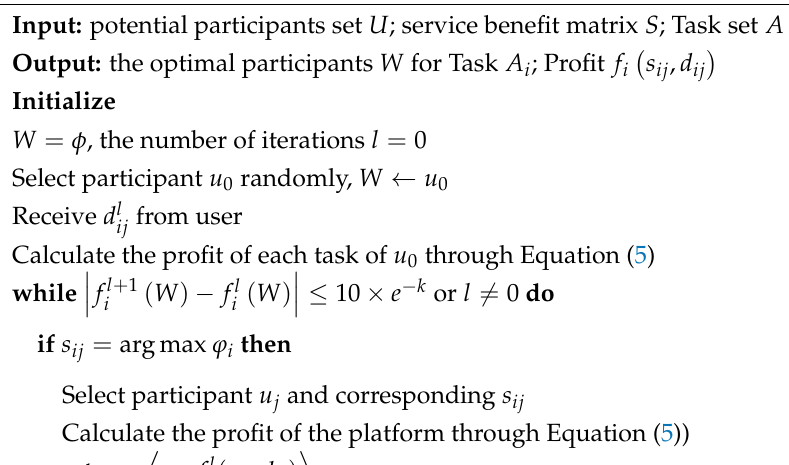
Algorithm 1 Service benefits.